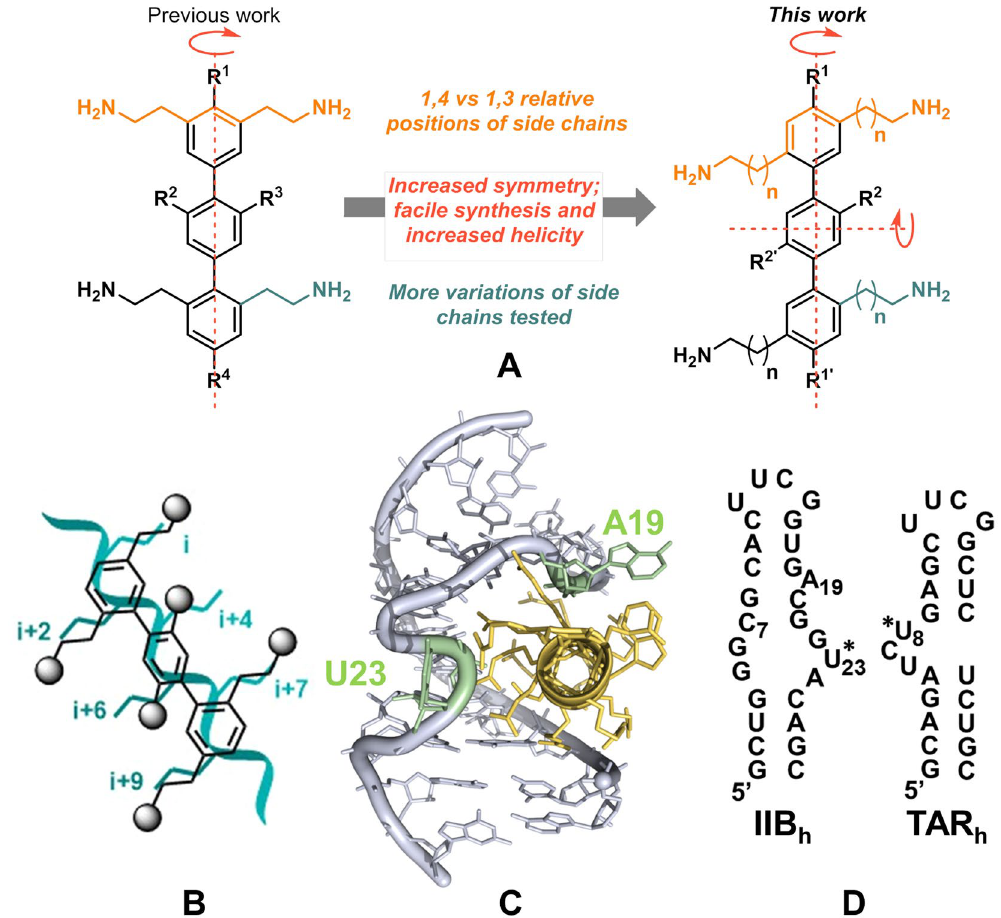
Figure 1. ( A ) Comparison of bilateral terphenyls with side chains in relative 1,3 (left) and 1,4 (right) positions. In both cases, the aminoalkyl side chains imitate the Arg residues of Rev. ( B ) Schematic overlay of a 1,4-bilaterally substituted terphenyl and a protein α -helix showing the mimicked residues (cyan). ( C ) Three- dimensional view of the complex formed between subdomain IIB of the RRE (grey) and the Rev 34–50 helix of the HIV-1 protein Rev (yellow) 12 . The extrahelical loop residues A19 and U23 are coloured light green. The image was generated with MOE 2019.0102 (www.chemcomp.com). ( D ) Secondary structure of RNA hairpins IIB h , containing the high-affinity Rev 34–50 binding site, and TAR h , used as a specificity control. For fluorescence intensity assays a fluorescein probe was linked to the extra-helical loop residues U23 of IIB h and U8 of TAR h (indicated with